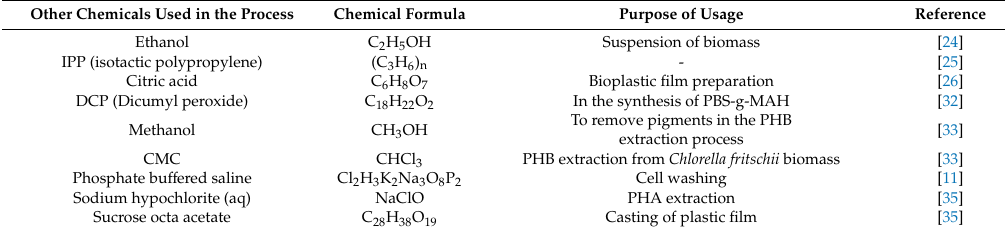
Table 7. Other chemicals used in the